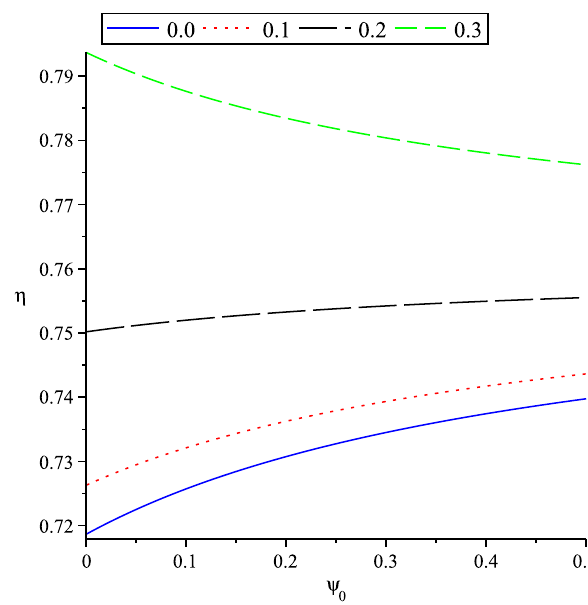
Fig. 9 Efficiency of the squared cycle as a function of the string cloud parameter σ for f ( R ) gravity, for several values of the parameter ψ 0